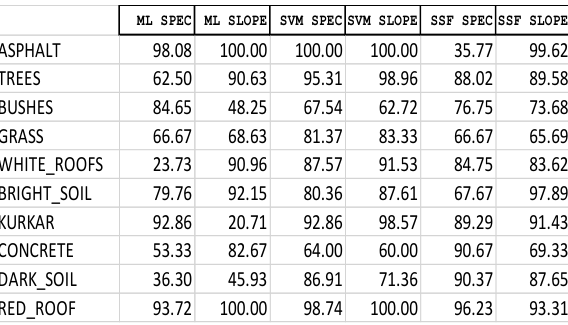
Table 1. mean accuracy of classification process of 3 classifiers based on spectral and slopes